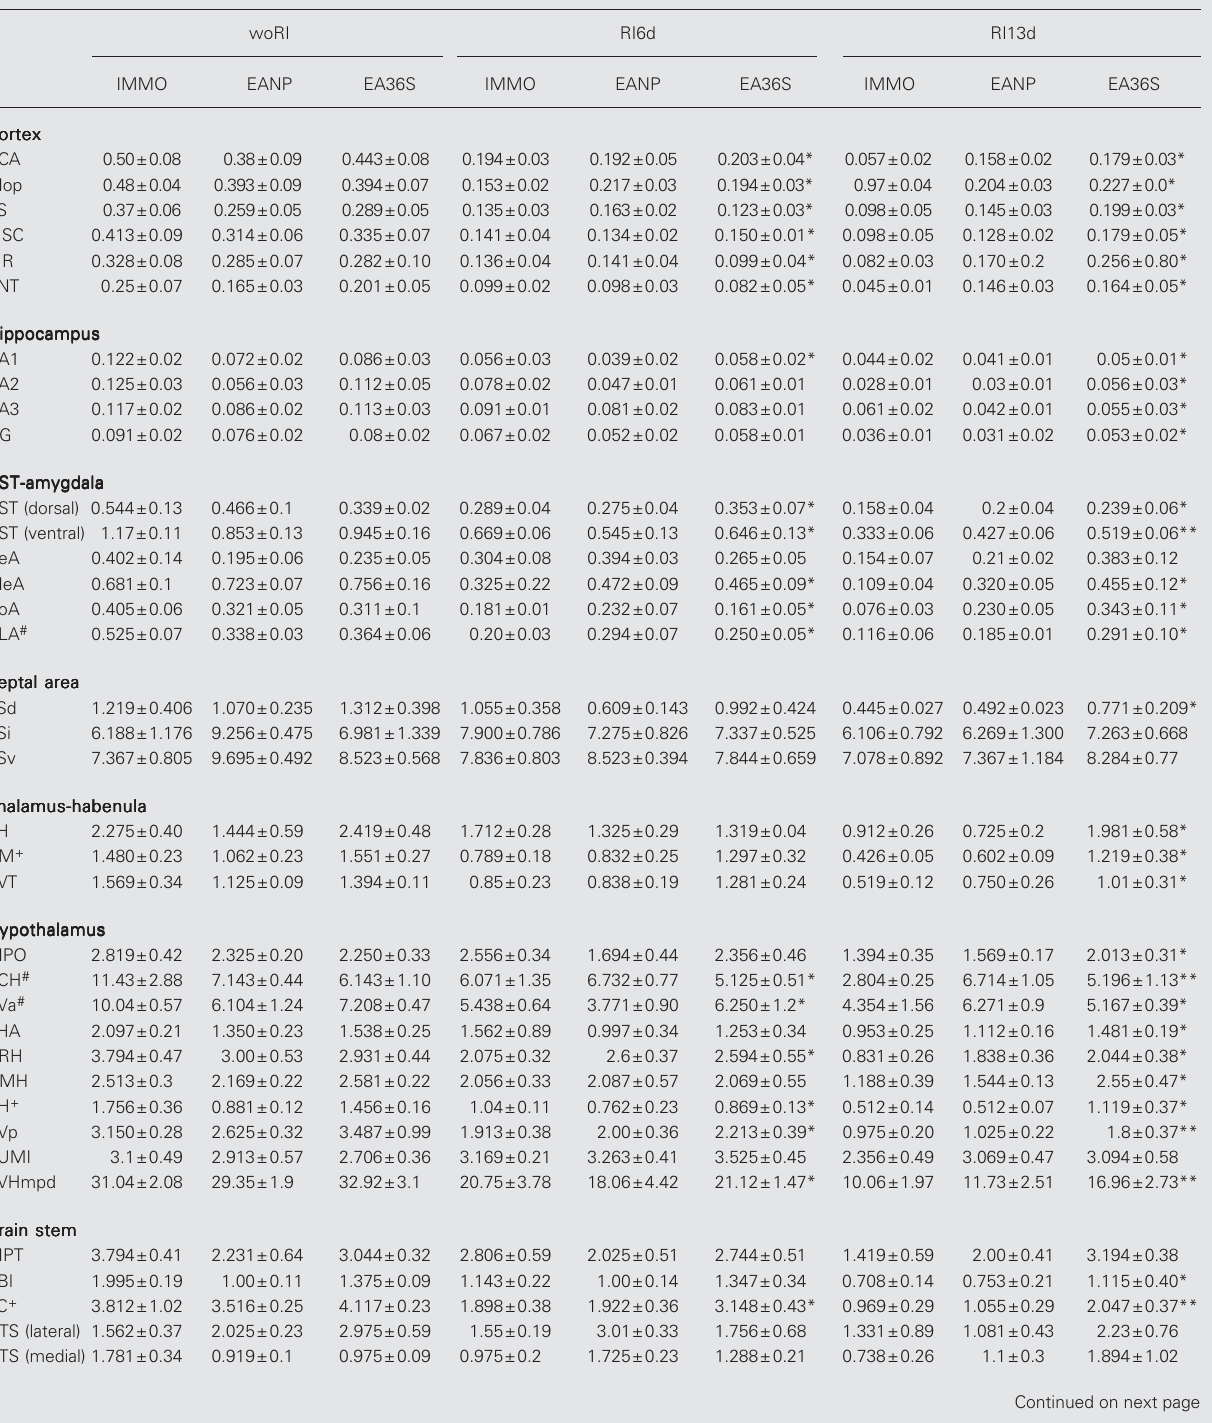
Table 1. Eletroacupuncture-induced c-Fos expression in the brain of previously immobilized